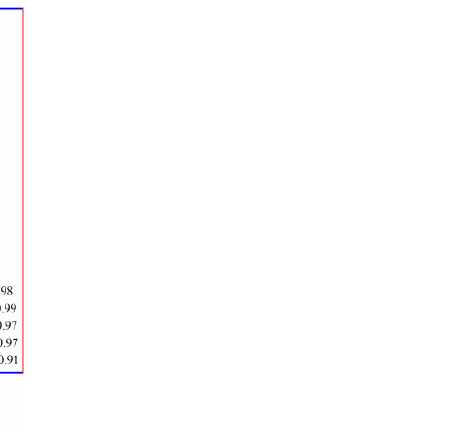
Figure 12. Fractal dimension curves of rocks with different levels of initial damage under the F-T effect.